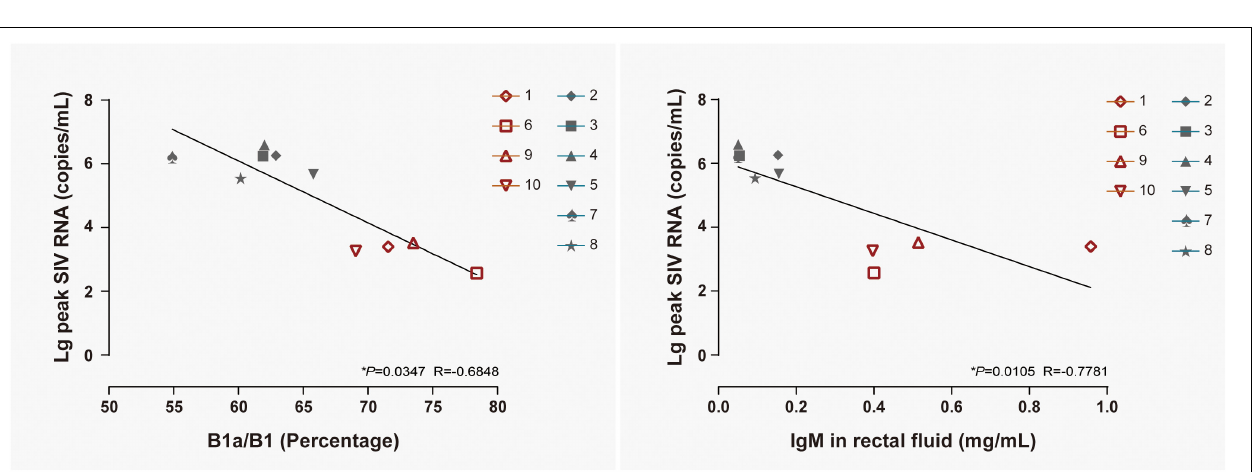
FIGURE 7 | Levels of IgM and IgG in rectal fluid in non-progressive and progressive monkeys. The levels of IgM and IgG were detected after initial exposure. A precipitously elevated IgM level in rectal fluid was found in four non-progressive monkeys during the early stage after initial exposure. In six progressive monkeys, a gradual increase in IgG was observed during the late stage 2 weeks after the first exposure. According to unpaired t test results, the level of IgM in the four non-progressive monkeys was significantly higher than that in the six progressive monkeys, whereas the level of IgG in the six progressive monkeys was significantly higher than that in the four non-progressive monkeys (* P < 0.01).